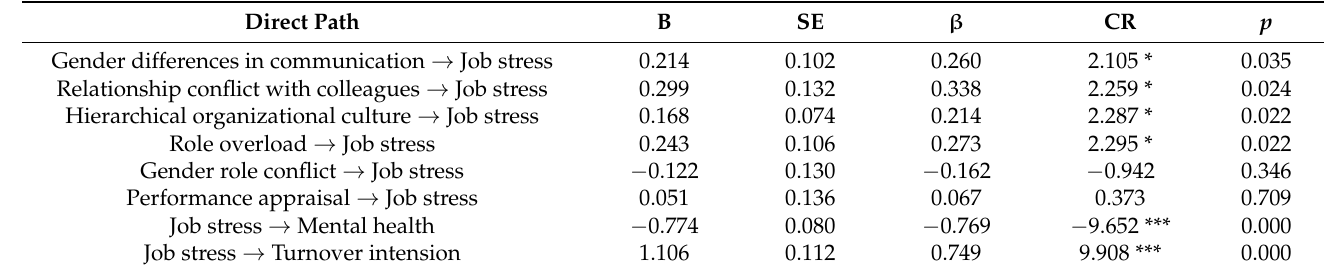
Table 8. Direct effects analysis results.